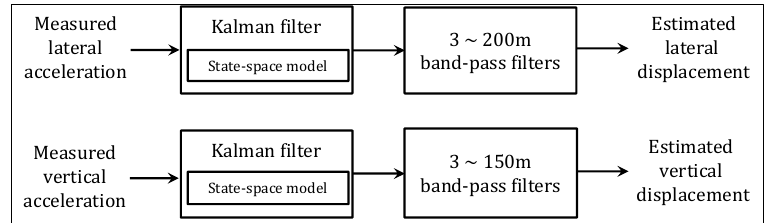
Figure 2. Displacement estimation from acceleration signals.